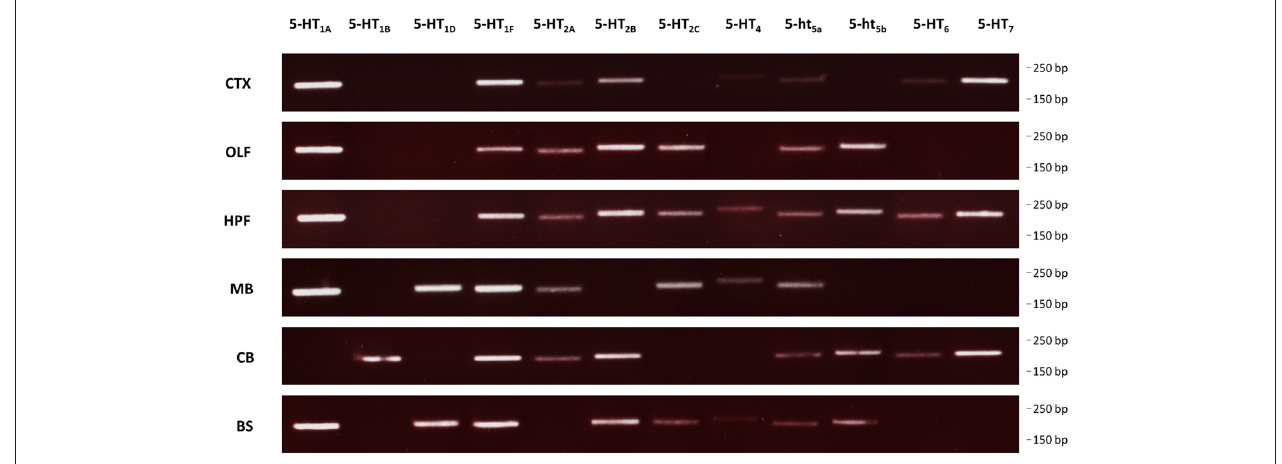
FIGURE 5 | Expression of 5-HT receptors in the mouse brain. RT-PCR was used to detect expression of all 5-HT receptors in select brain regions of mice. CTX, cortex; OLF, bulbus olfactorius; HFP, hippocampal formation; MB, midbrain; CB, cerebellum; BS, brainstem.